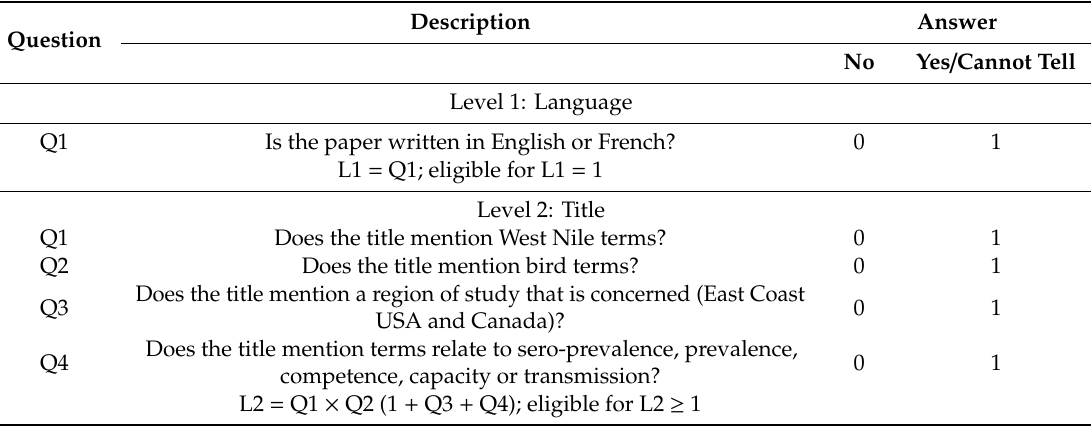
Table 1. Search strategy for the literature